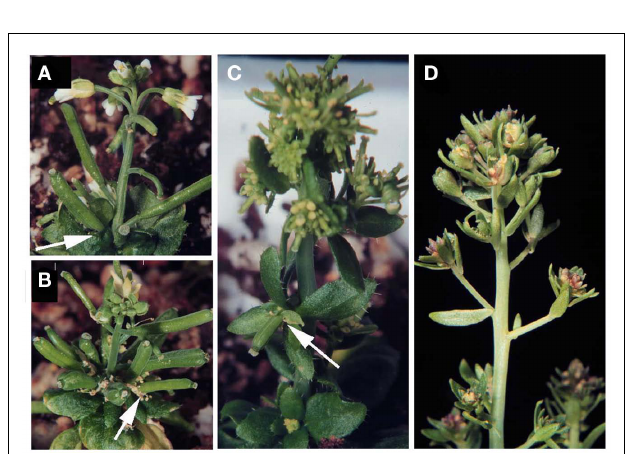
rescue of the floral homeotic defects (B,C) , while treatment on day 13 resulted in full rescue of the floral homeotic defects of lfy-6 flowers. (E) The ratio of plants exhibiting a given response over the total number of plants per treatment day (% response) was determined. For each treatment day 20–30 plants were scored after bolting. lfy-6 35S:LFY-GR plants were assayed for partial floral rescue ( ) or full floral rescue (fertile flowers)( ).